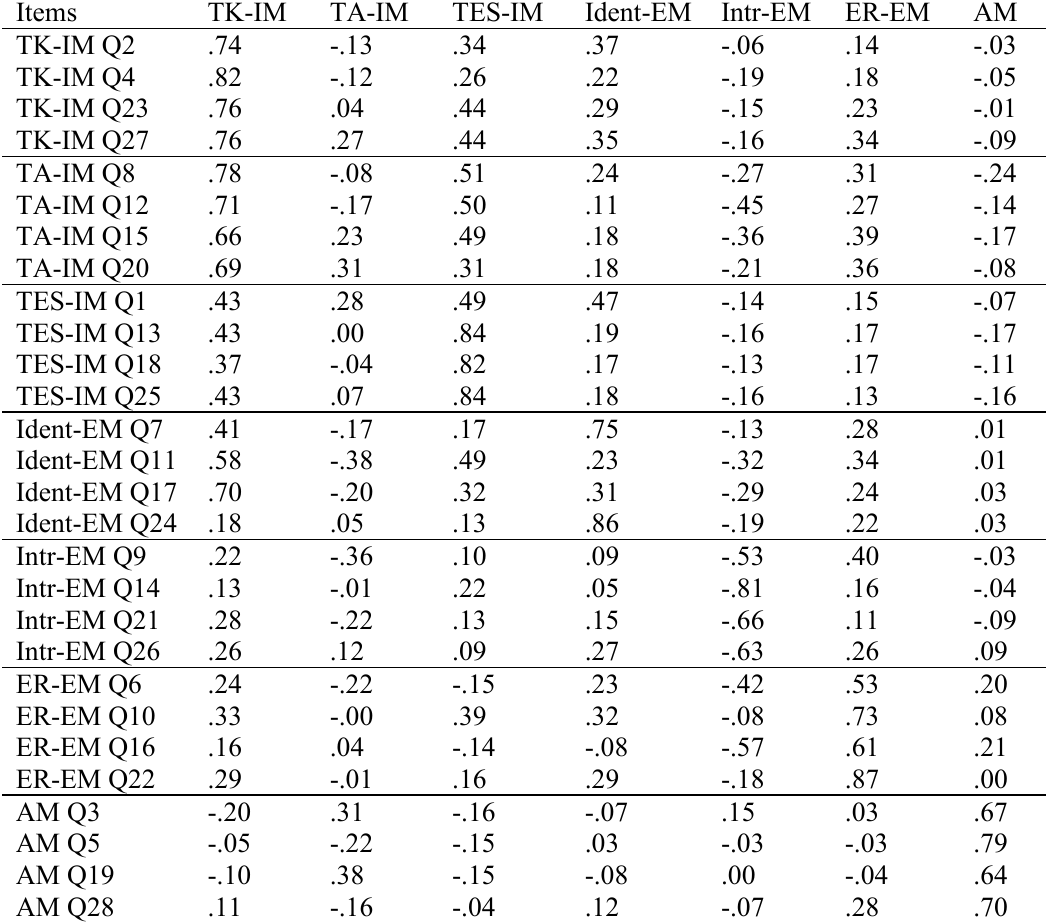
Table 2. Factor loadings for principal components factor analysis with direct oblimin rotation of items of the